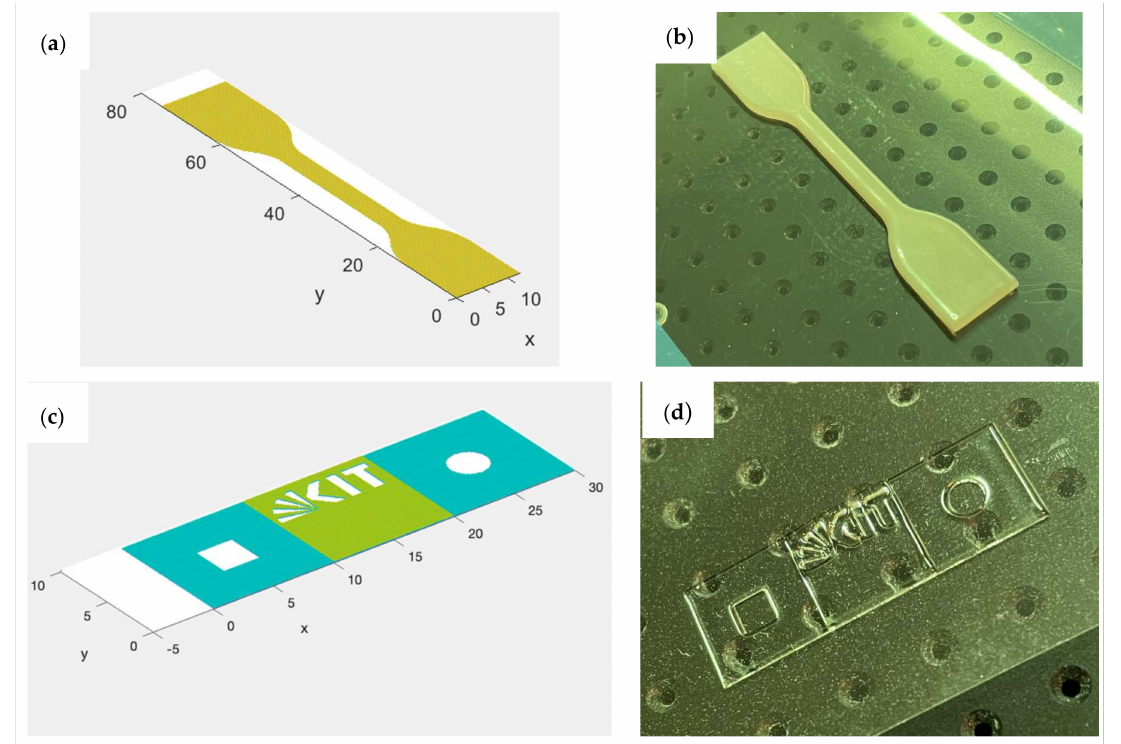
Figure 18. Experimentally validated samples, ( a ) a simulated dogbone sample ( b ) a printed dogbone part, ( c ) a simulated “KIT logo” sample and ( d ) a 3D-printed “KIT logo” part.